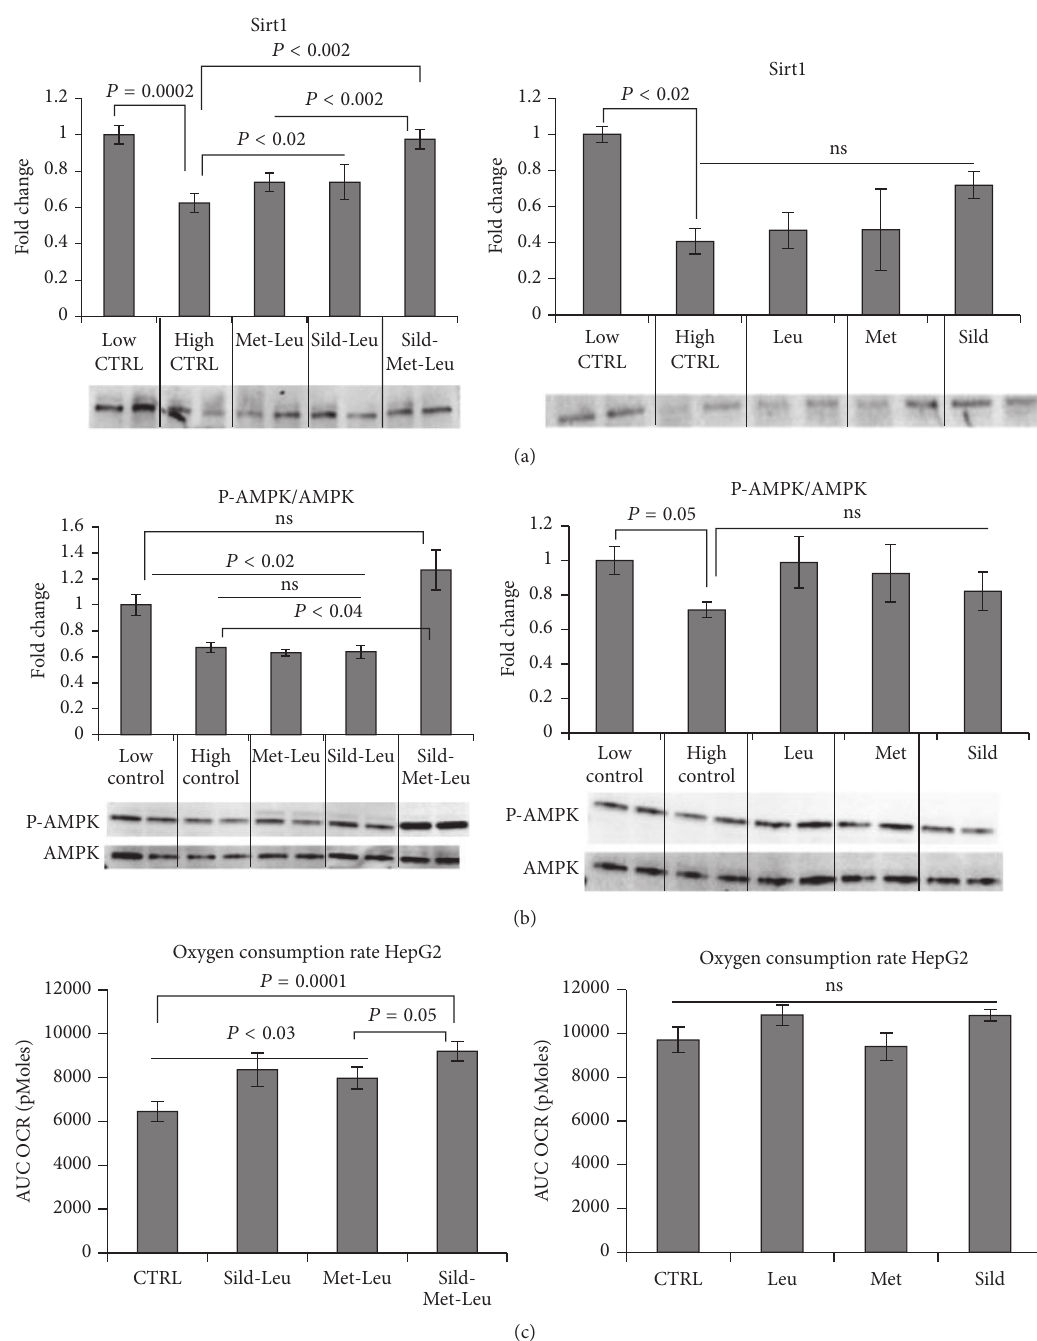
Figure 1: Sild-Met-Leu treatment in hepatocytes increases AMPK and Sirt1 activation and stimulates fatty acid oxidation. HepG2 cells were treated with sildenafil (Sild, 1nM), metformin (Met, 0.1mM), and leucine (Leu, 0.5 mM) as indicated for 24 hours after induction of lipid accumulation and compared to nontreated cells (control or CTRL high) after lipid accumulation and without lipid accumulation (CTRL low). (a) Sirt1 and (b) AMPK and phospho-AMPK protein expression was measured via Western blotting. Representative blots are shown. Data from repeated experiments are analyzed and presented as mean ± SEM ( 𝑛 = 2 to 8). (c) Oxygen consumption rate (OCR) after 200 𝜇 M palmitate injection was measured and the area under the curve (AUC) was calculated. Data are represented as mean ± SEM ( 𝑛 = 5